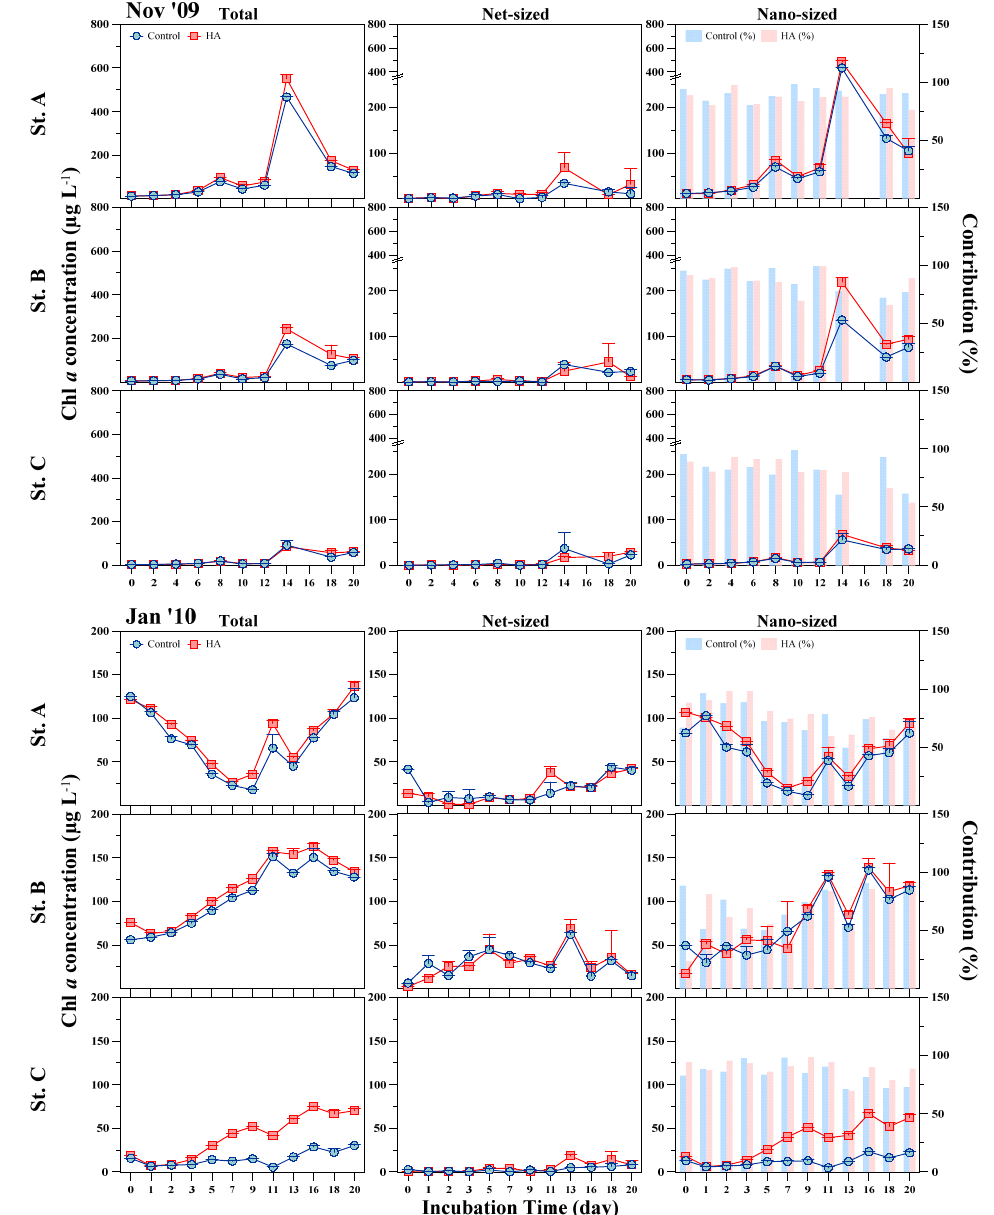
Figure 3. Size ‐ fractionated chl a concentration ( μ g L − 1 ) and contribution percentage (%) of nanosize class during the mesocosm experiments for water samples collected at St. A, B, and C in November 2009 and January 2010.